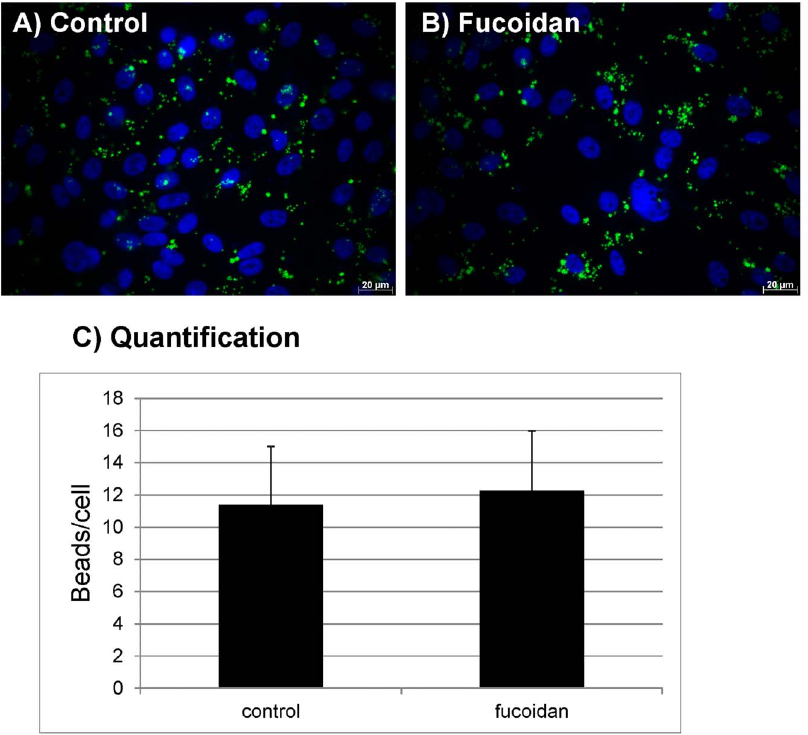
Figure 2. Phagocytosis. Primary RPE cells were stimulated with 100 m g/ml fucoidan for 1 hour. RPE cells were exposed to FITC-labeled, photoreceptor outer segment opsonizedbeadsfor4 hours anduptake of thebeads was evaluated influorescence microscope.No influenceof fucoidan on RPE phagocytosis was found. A) control, B) fucoidan, C) quantification of uptaken beads. Significance was determined with student’s t-test.